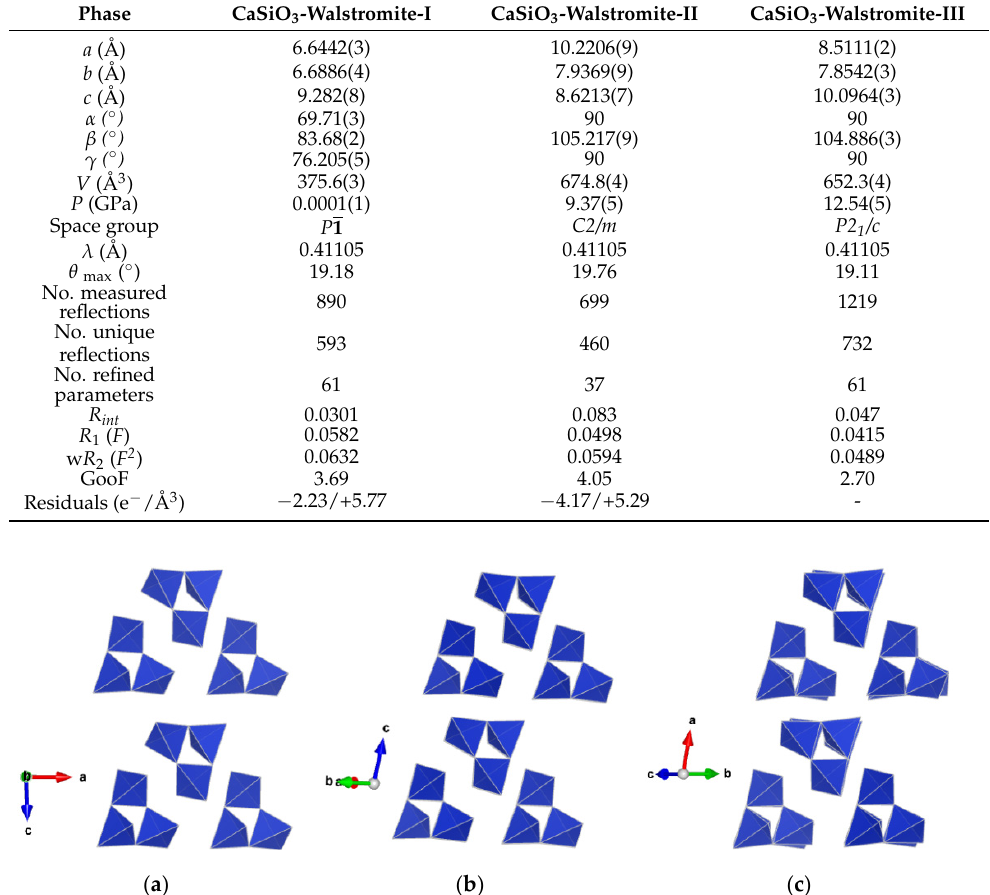
Table 5. Details pertaining to the data collections and structure refinements of CaSiO 3 -walstromite studied in this work.